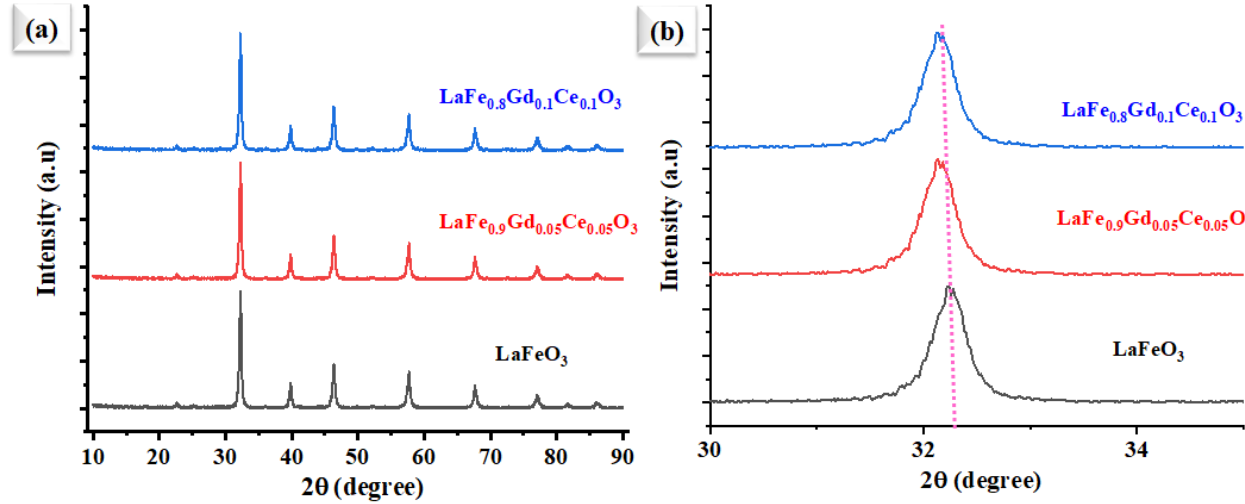
Figure 1. ( a ) measured X-ray diffraction pattern of LaFeO 3 , LaFe 0.9 Gd 0.05 Ce 0.05 O 3- δ , and LaFe 0.8 Gd 0.1 Ce 0.2 O 3- δ , respectively. ( b ) Comparison of peak shifting of LaFeO 3 with Gd and Ce doping.